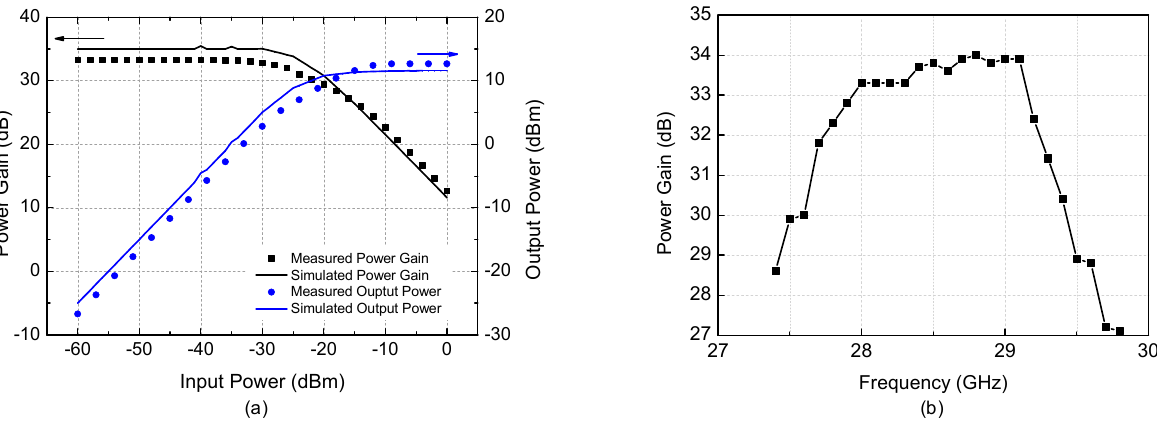
Figure 11. Measured results. ( a ) Input-to-output power transfer characteristics. ( b ) Power gain over the operating frequency.